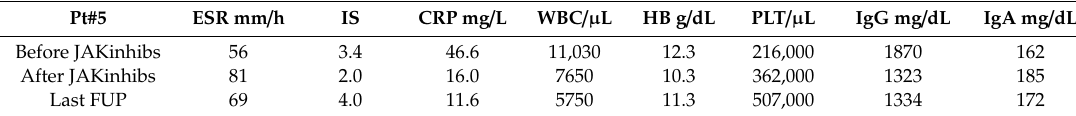
Table A5. Patient #5 laboratory findings.